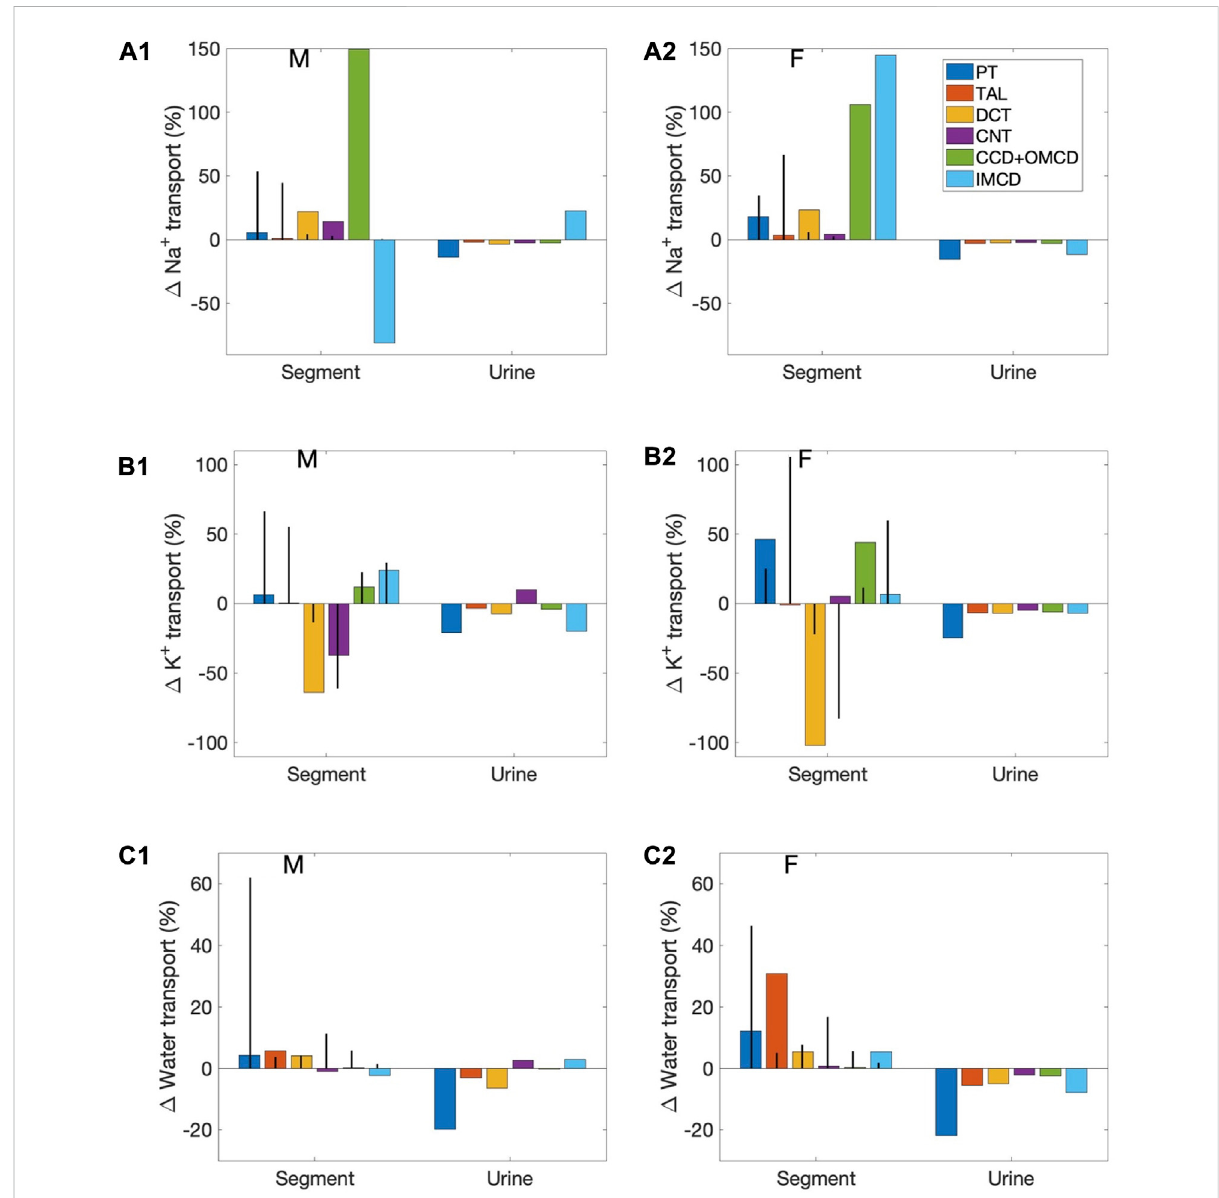
Effects on segmental transport and urine excretion if transporter abundance in individual segments was set to values in the sex-matched rat. Results show 1) fractional changes in in Na + transport (A1 , A2) , K + transport (B1 , B2) , and water transport (C1 , C2) along each nephron segment in the malemouse (A1 , B1 , C1) andfemalemouse (A2 , B2 , C2) iftransporterabundanceinindividual segmentsweresetto valuesinthesex-matchedrat,and 2) Na + excretion, K + excretion, and urine output. Six segments were considered individually: proximal tubule (PT), thick ascending limb (TAL), distal convoluted tubule (DCT), connecting tubule (CNT), cortical and outer-medullary collecting ducts (CCD + OMCD), and inner-medullary collecting duct (IMCD). Middle bars (vertical lines) indicate fractional transport mediated by that segment under baseline